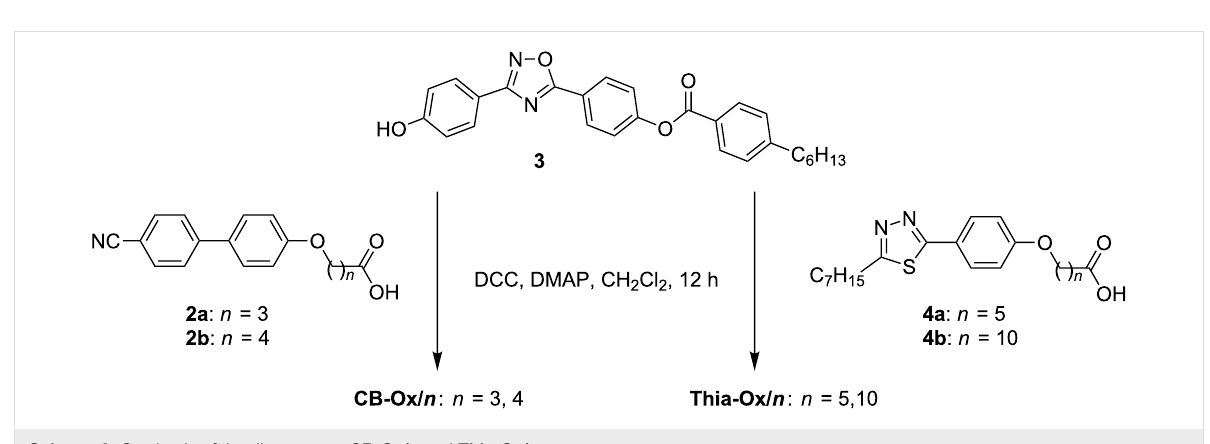
Scheme 3: Synthesis of the dimesogens CB-Ox/ n and Thia-Ox/ n